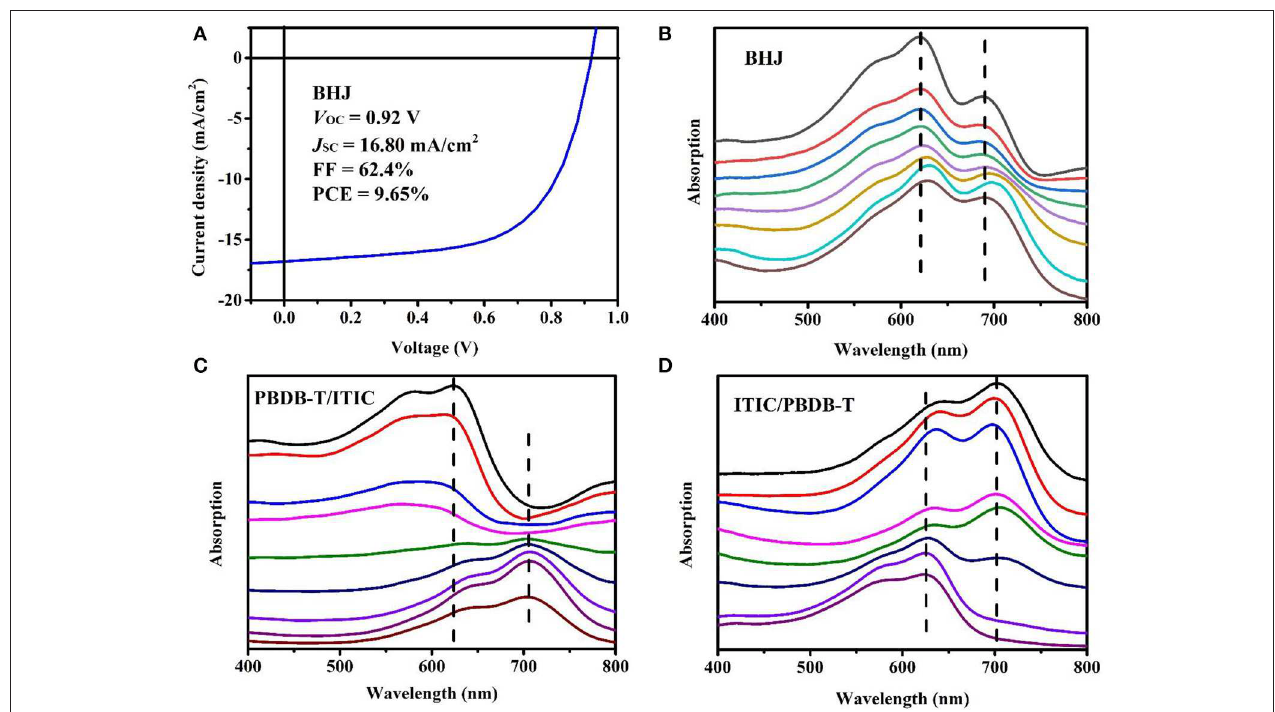
FIGURE 5 | Device performance and film-depth-dependent light absorption spectra (FLAS). (A) J–V characteristic curve of bulk heterojunction (BHJ) device under illumination of solar simulator (AM 1.5G, 100 mW/cm 2 ). (B–D) FLAS of BHJ and bilayer. (B) Poly{(2,6-(4,8-bis(5-(2-ethylhexyl)thiophen-2-yl)-benzo[1,2-b:4,5-b ′ ] dithiophene))-alt-(5,5-(1 ′ ,3 ′ -di-2-thienyl-5 ′ ,7 ′ -bis(2-ethylhexyl)benzo[1 ′ ,2 ′ -c:4 ′ ,5 ′ -c ′ ]dithiophene-4,8-dione))}:3,9-bis{2-methylene-[3-(1,1-dicyanomethylene)- indanone]}-5,5,11,11-tetrakis(4-hexylphenyl)-dithieno[2,3-d:2 ′ ,3 ′ -d ′ ]-s-indaceno[1,2-b:5,6-b ′ ]dithiophene (PBDB-T:ITIC) (1:1) BHJ. The dashed lines show that the absorption peak varies with film depth. (C) PBDB-T/ITIC bilayer configuration with PBDB-T layer at the top and ITIC layer at the bottom, as prepared by layer-by-layer transferring method. (D) ITIC/PBDB-T bilayer configuration with ITIC layer at the top and PBDB-T layer at the bottom. ITIC was blended with some polystyrene to warrant the film transferring. The upper sublayer spectrum corresponds to the top of film, and the lower sublayer spectrum corresponds to the bottom of film. The spectra are shifted along the vertical direction for clarity. The sublayer thickness corresponding to each spectrum is ∼